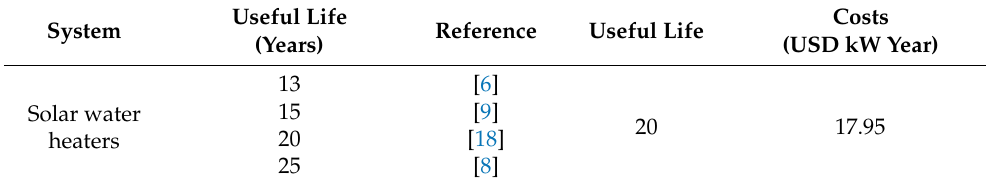
Table 17. Data used for the calculation of energy cost for DHW.